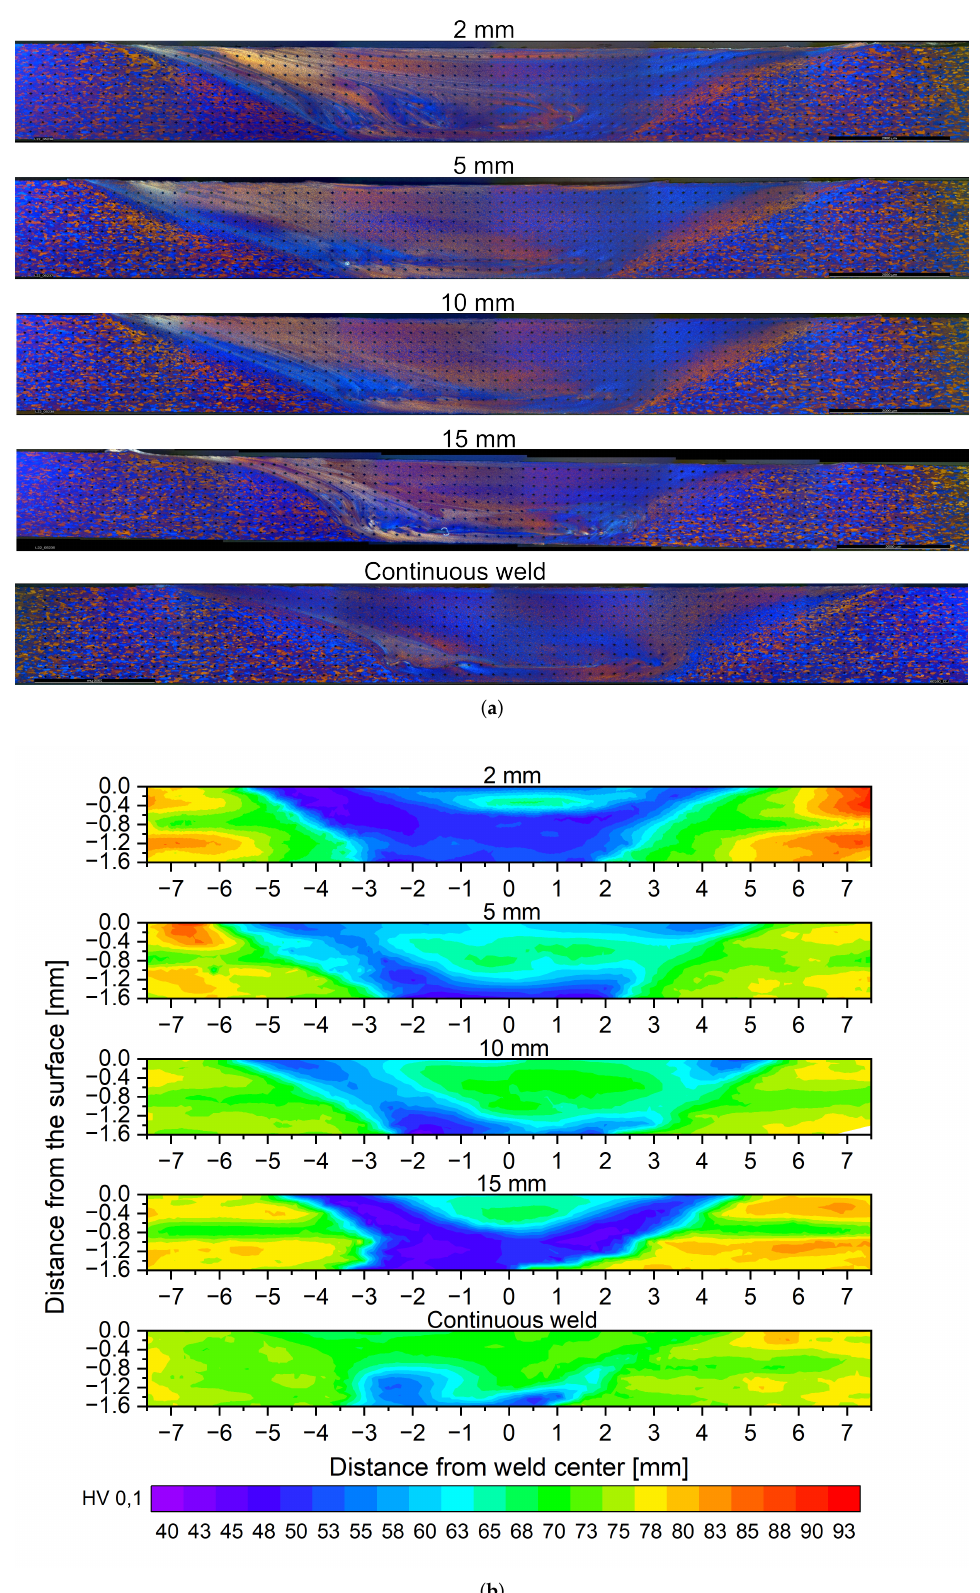
Figure 8. Results of the microscopic investigation and the hardness measurements. ( a ) crosssections of the stitch welds etched with Barker ´ s etchant and photographed under polarized light; ( b ) HV0,1 Hardness map of the cross sections of the stitch welds and the continuous